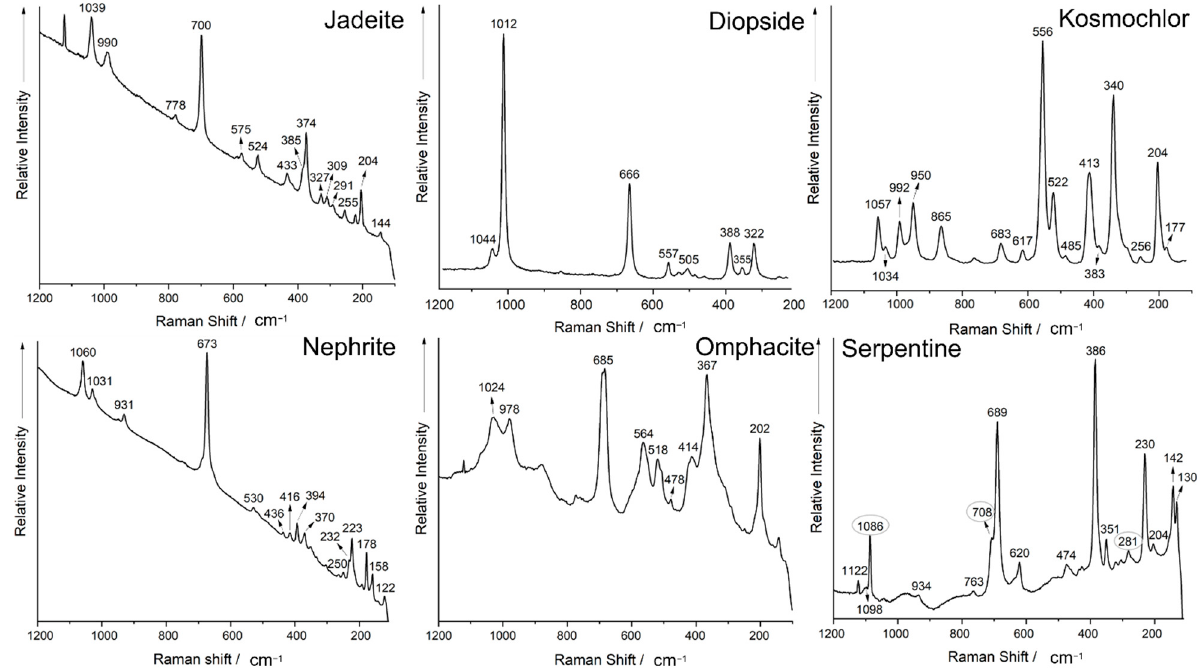
Figure 5. Reference Raman spectra of several Green Stones samples. Kosmochlor spectrum is re- plotted from the RRUFF reference N. R120015 [127]; the other spectra have been acquired by In-Via Confocal micro-Raman Spectroscope, Renishaw, 514.5/632.8 nm sources and elaborated using Origin 2020 software by the author on GECI Reference stones collection. Circled bands in the serpentine spectrum are consistent with calcite phase associated with serpentine.